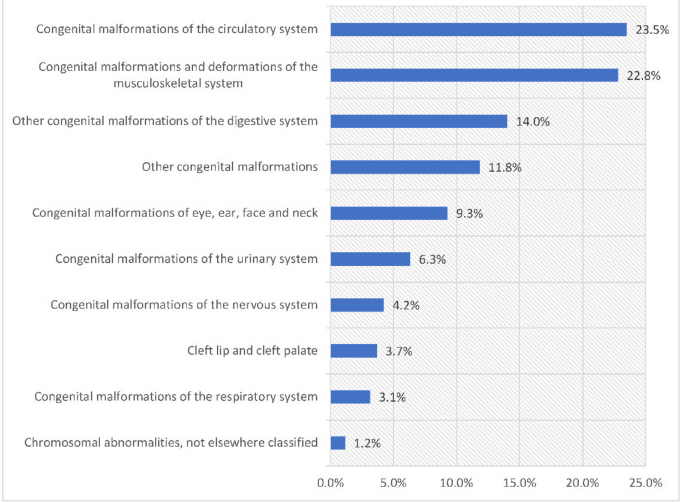
Figure 6. Percentage of congenital malformations, deformations and chromosomal abnormalities hospital admission from total number of